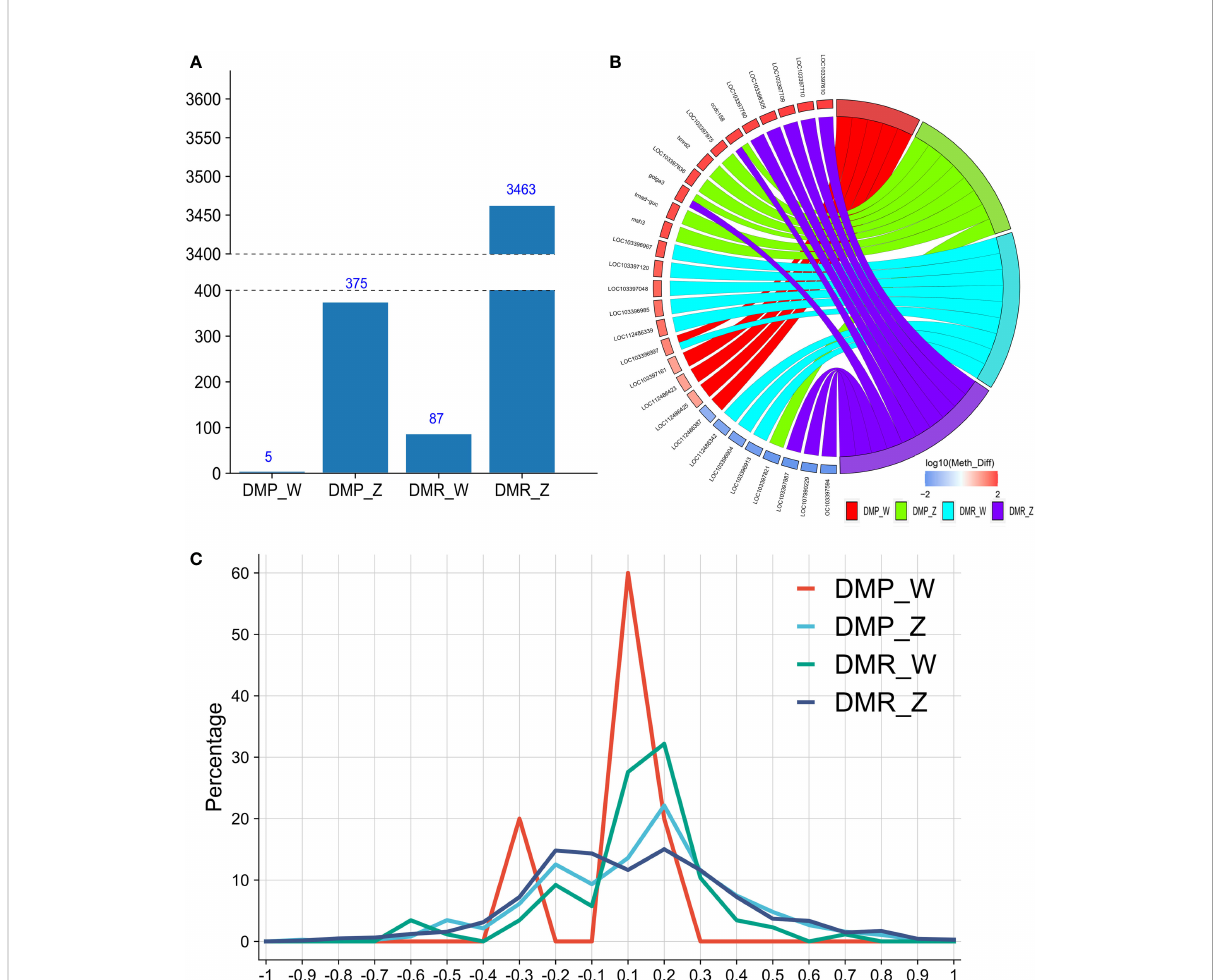
FIGURE 5 Distribution of DMRs/DMPs on sex chromosomes of ZW and ZZ groups. (A) Number of DMPs/DMRs annotated on W and Z chromosomes of C.semilaevis of both ZW and ZZ groups (methyl diff ± 0.1, P value less than 0.05). (B) Chord diagram of top eight DMR/DMP related genes with the most signi fi cant methylation differences of DMP-W, DMP-Z, DMR-W, and DMR-Z groups (Ranged from large to small according to absolute value of methyl diff). (C) Line diagram of the interval distribution of DMP/DMR on Z and W chromosomes. Red line represents DMP-W; Blue line represents DMP-Z; Green line represents DMR-W; Dark blue represents